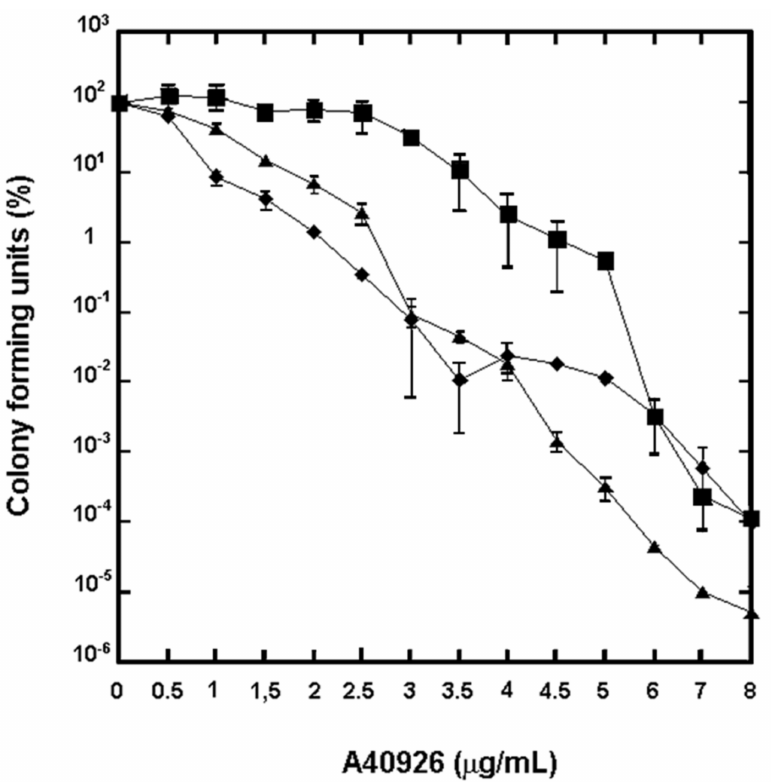
Figure 2. Population analysis profiles of N. gerenzanensis . Cfu growing in the presence of increasing concentrations of A40926 in the wild-type (filled triangles) and in the two selected populations, G (filled rectangles) and P (filled rhombi). Three colonies for each population were tested in parallel, and results are the average of three independent experiments. Bars indicate ± standard